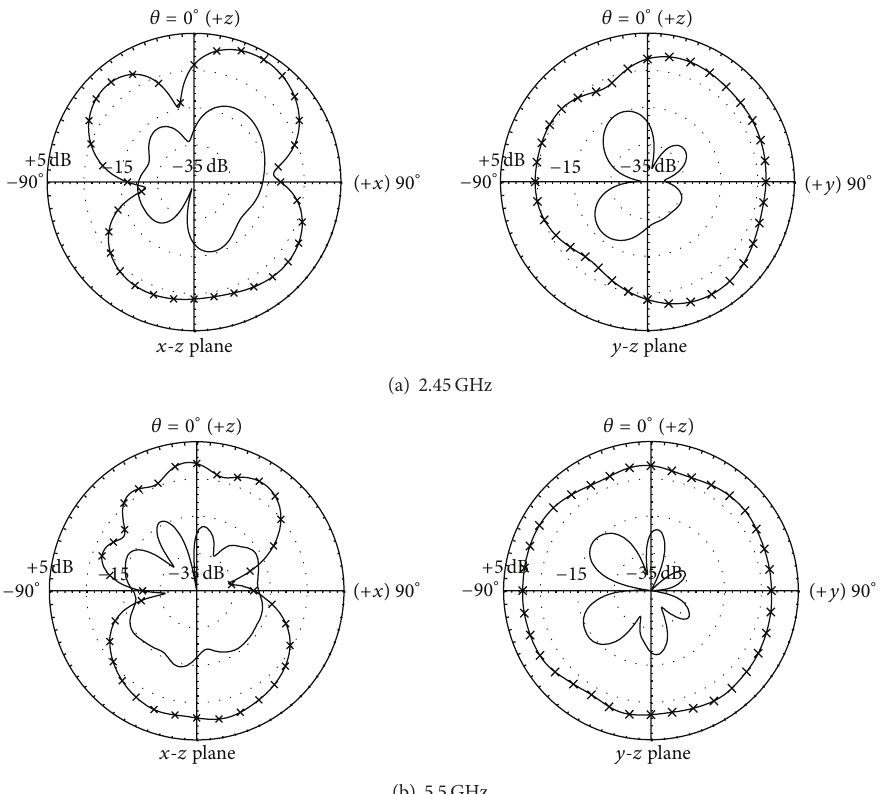
Figure 4: Measured radiation patterns of proposed antenna obtained at (a) 2.45 and (b) 5.5 GHz. – × – copolarization — cross-polarization.